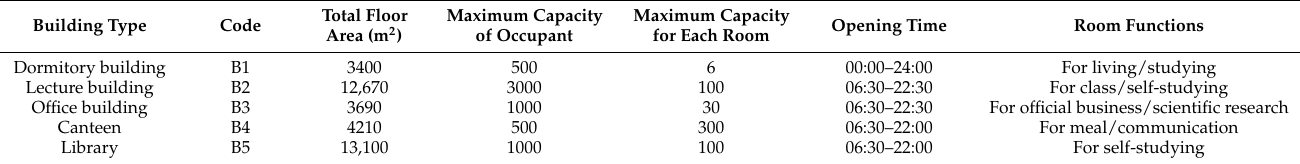
Table 3. Basic information for target